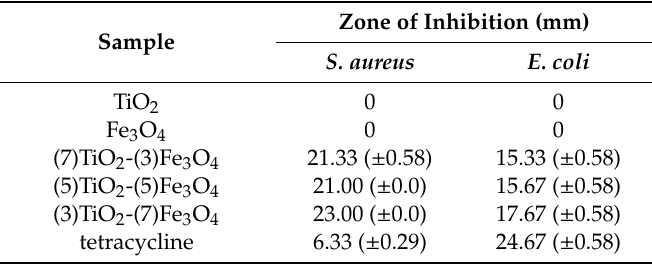
Table 4. The zone of inhibition of the tested TiO 2 -Fe 3 O 4 composite materials and control samples.